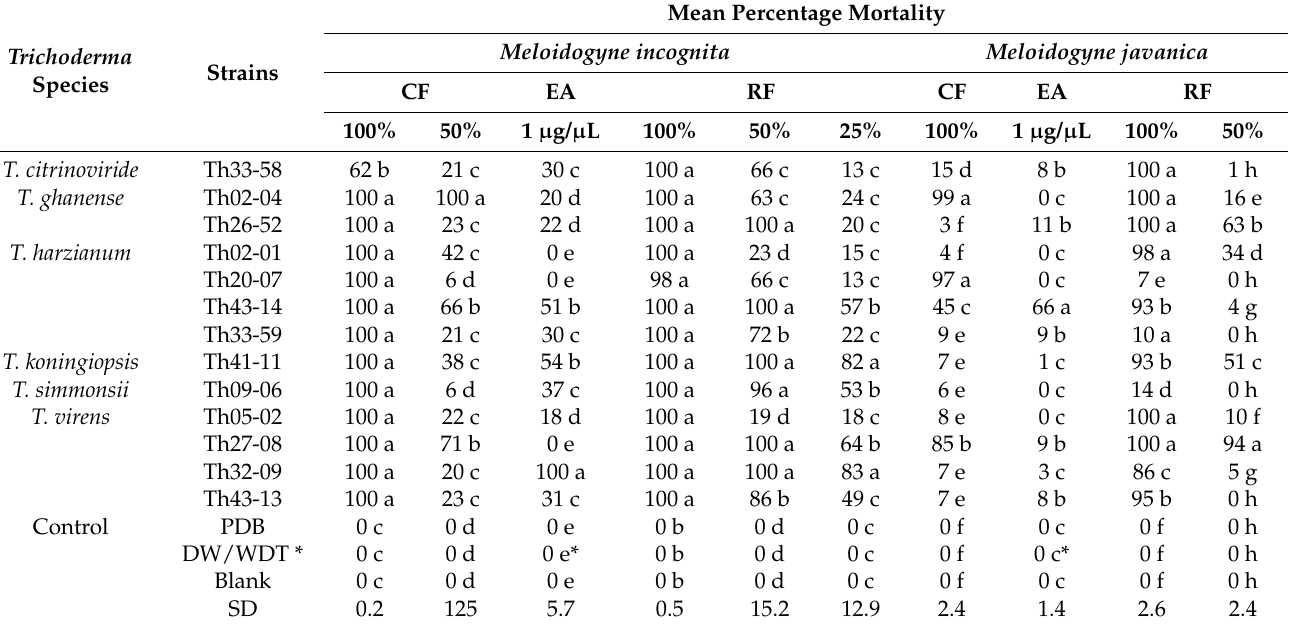
Table 2. Mortality of second-stage juveniles of Meloidogyne spp. after 72 h exposure to culture filtrate (CF), ethyl acetate (EA), or residual filtrate (RF) fractions from tropical Trichoderma